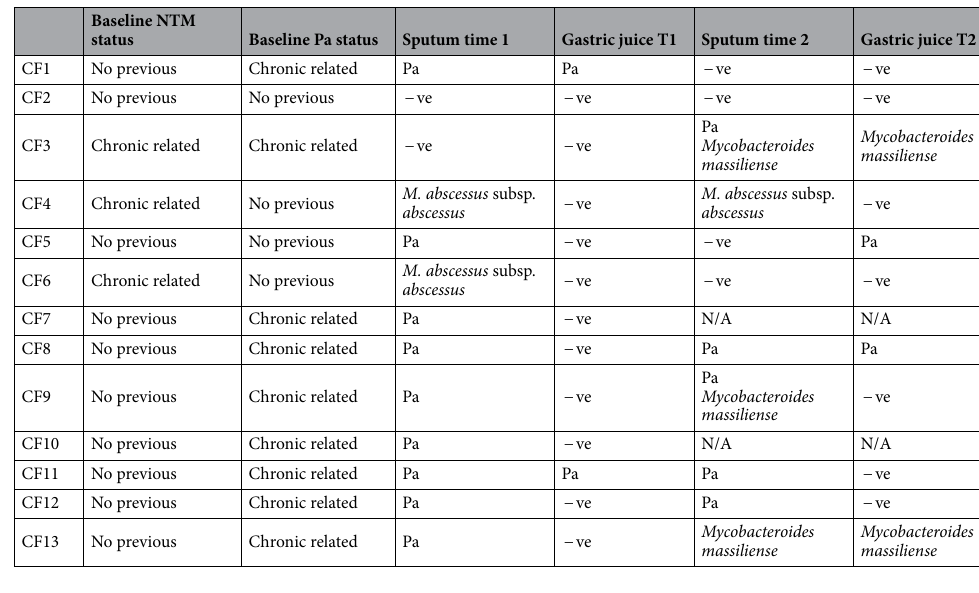
Table 2. Pa and NTM status among CF gastric juice (GJ) and sputum samples taken at different time points 6 months apart (T1 and T2) using routine culture approaches previously outlined 9 . Cultures which were negative for Pa and NTM are denoted as –ve, N/A indicates that culture data is unavailable. Chronic related indicates where the organisms were present over time, and shown to be related to previous isolates from the same patient (VNTR).